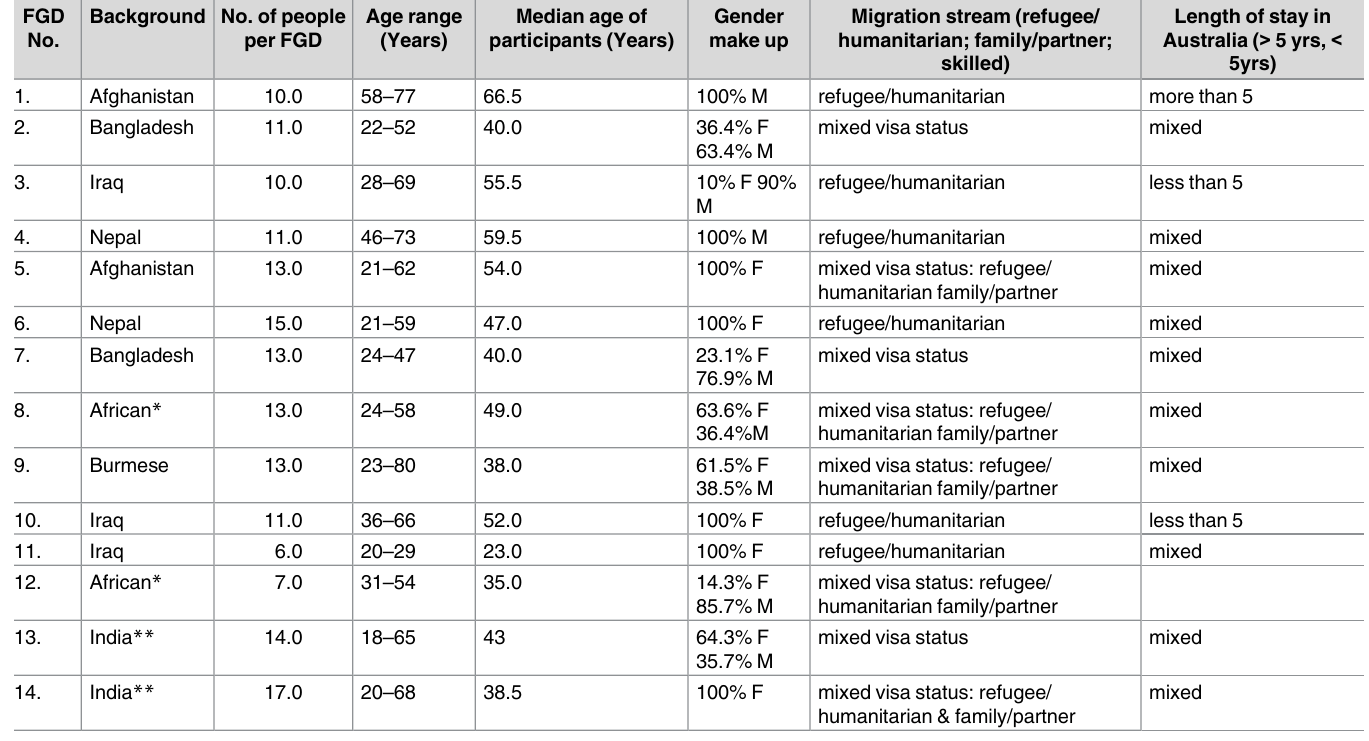
Table 1. Demographics characteristics of focus group participants, listed in the order conducted. FGD